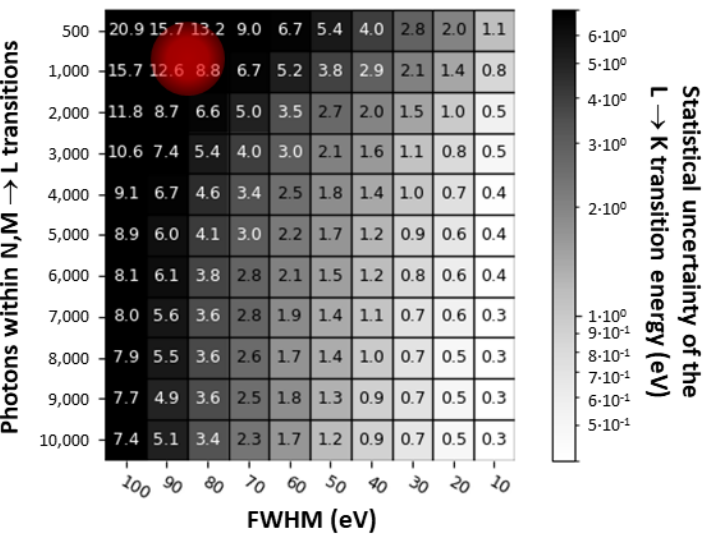
Figure 4. Simulated uncertainty in eV due to the Doppler correction of a transition line with an energy of 100keV in the emitter system, i.e., a L → K transition in a high- Z ion. For each pair of differing numbers of detected photons and detector resolution, 500 individual N, M → L spectra were generated for the 0 ◦ position via a Monte Carlo method. For reference, the detector resolution and number of photons obtained from preliminary analysis of the experimental data are indicated by the red